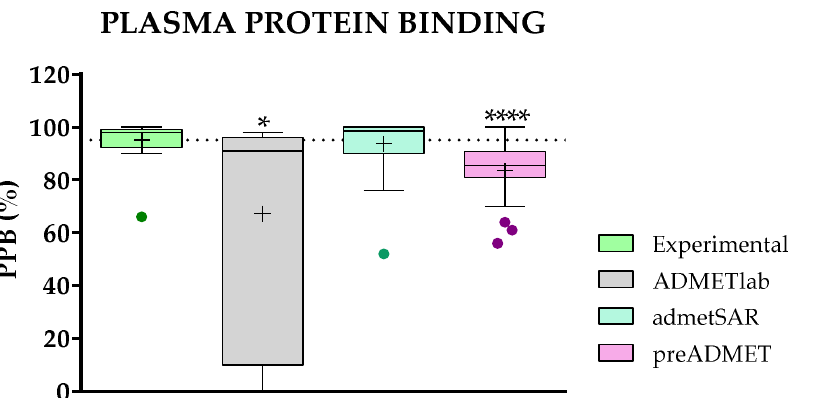
Figure 7. Comparison of experimental and predicted data for plasma protein binding (PPB) between ADMETlab, admetSAR, and preADMET. Statistical analysis was performed by a pairwise t -test ( n = 24, * p ≤ 0.05, ** p ≤ 0.01, *** p ≤ 0.001, and **** p ≤ 0.0001) versus experimental data.